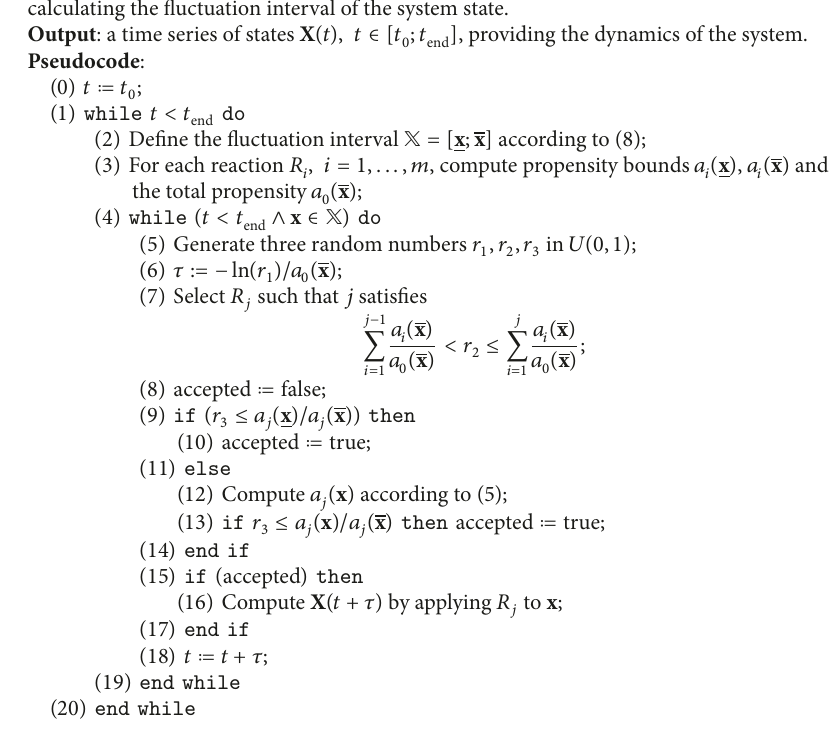
Algorithm 2: Rejection-based Stochastic Simulation Algorithm